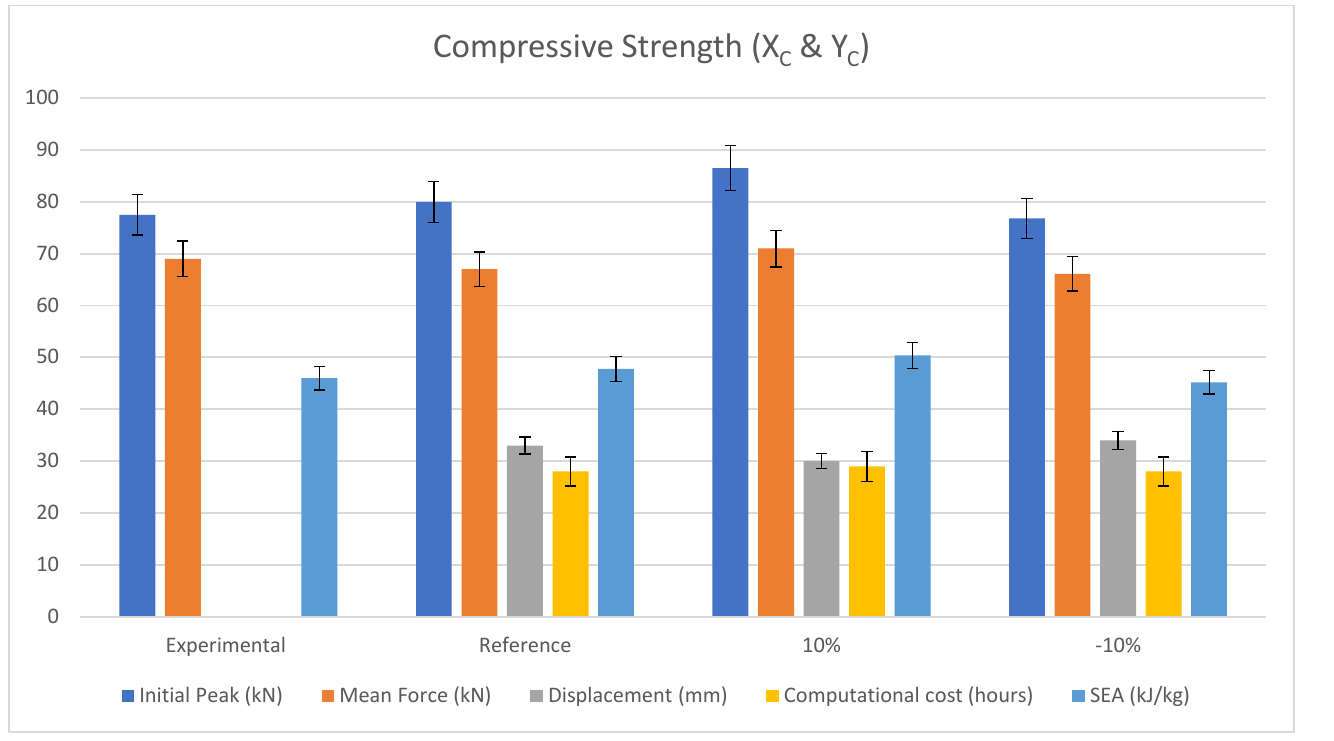
Figure 14. Compressive strength comparison [66].